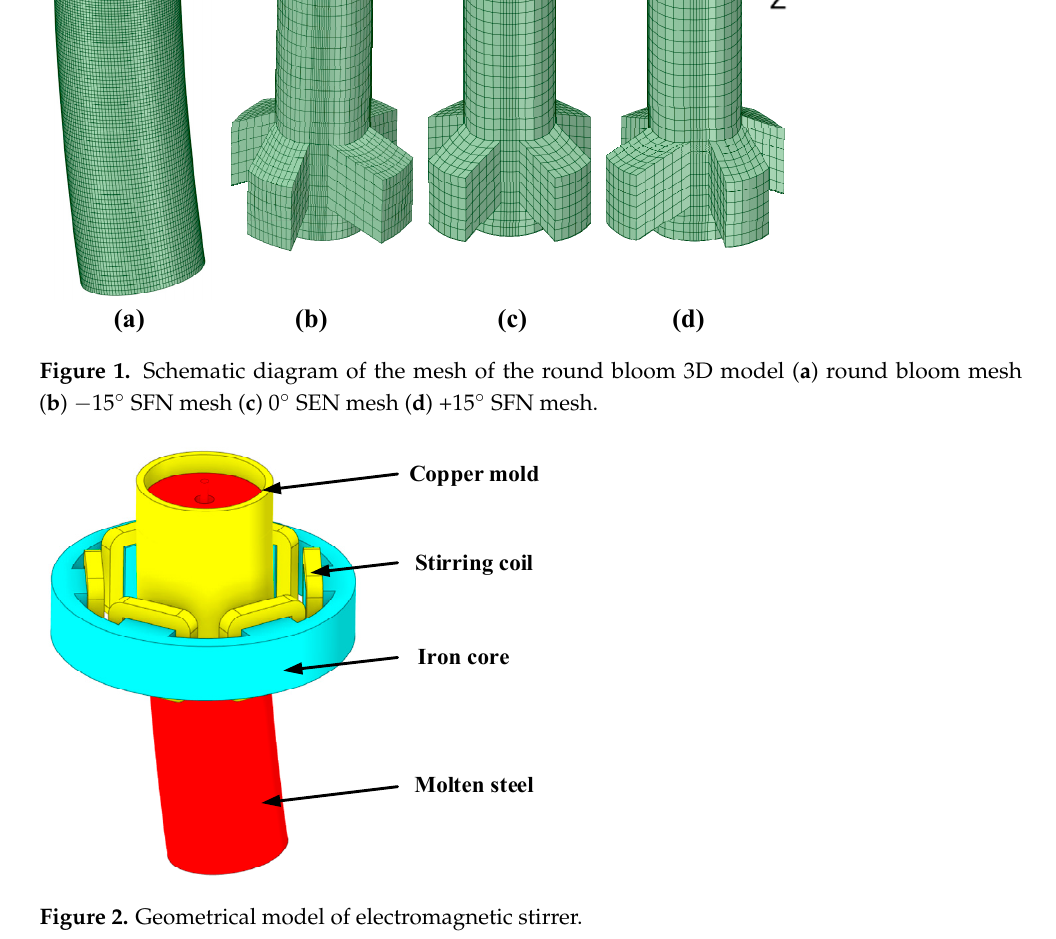
Table 3. Process conditions and physical